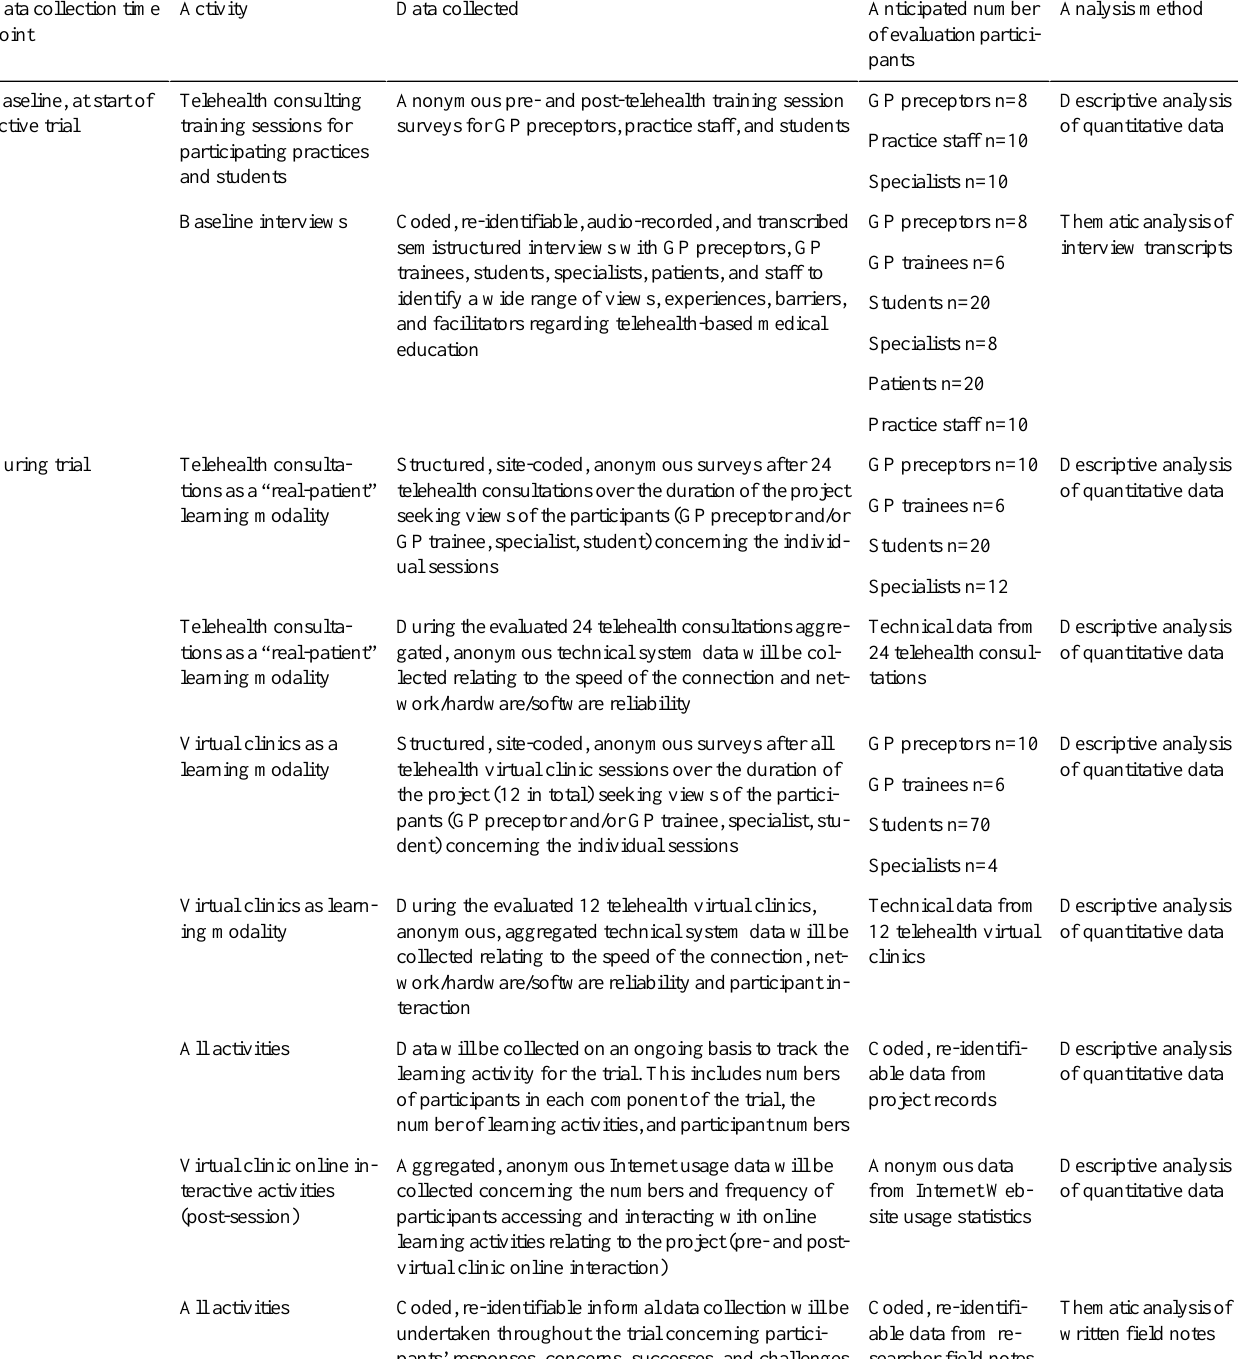
Table 3. Data collection schedule and